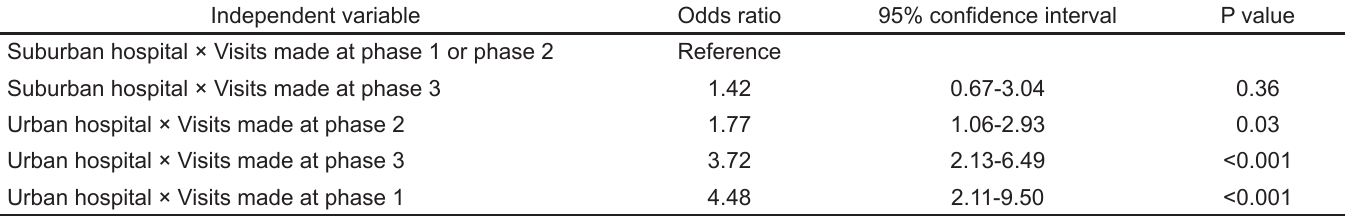
Table 3. Interaction analysis between hospital level and different phases during the